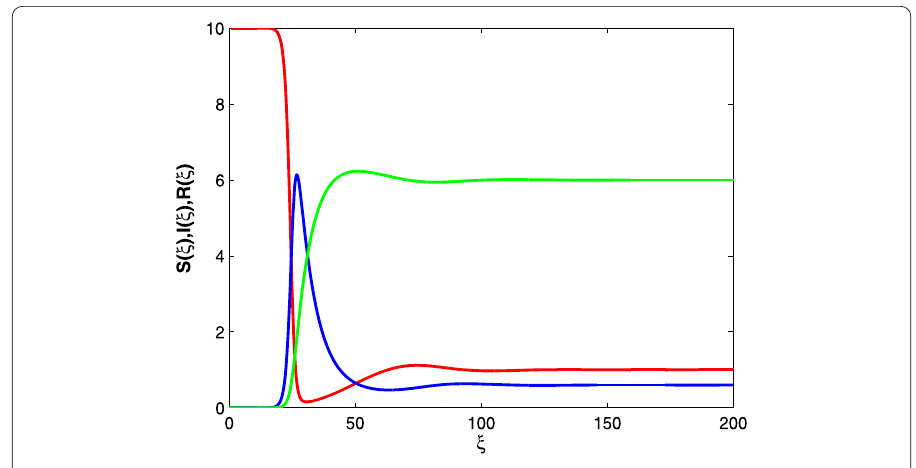
Figure 1 When the incidence function is bilinear, that is, f ( S , I ) = SI , then system (4) admits a solution ( S ∗ ( ξ ), I ∗ ( ξ ), R ∗ ( ξ )) connecting E 0 ( S 0 ,0,0) with E ∗ ( S ∗ , I ∗ , R ∗ ) for c > c ∗